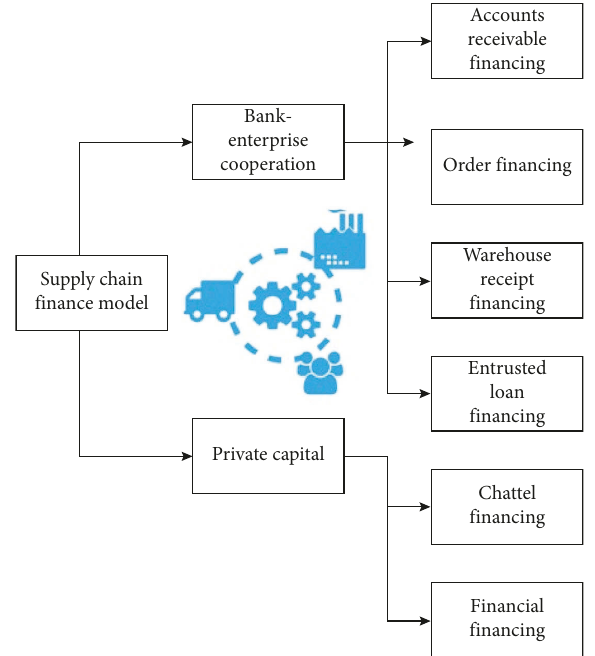
Figure 1: Supply chain finance development with machine learning